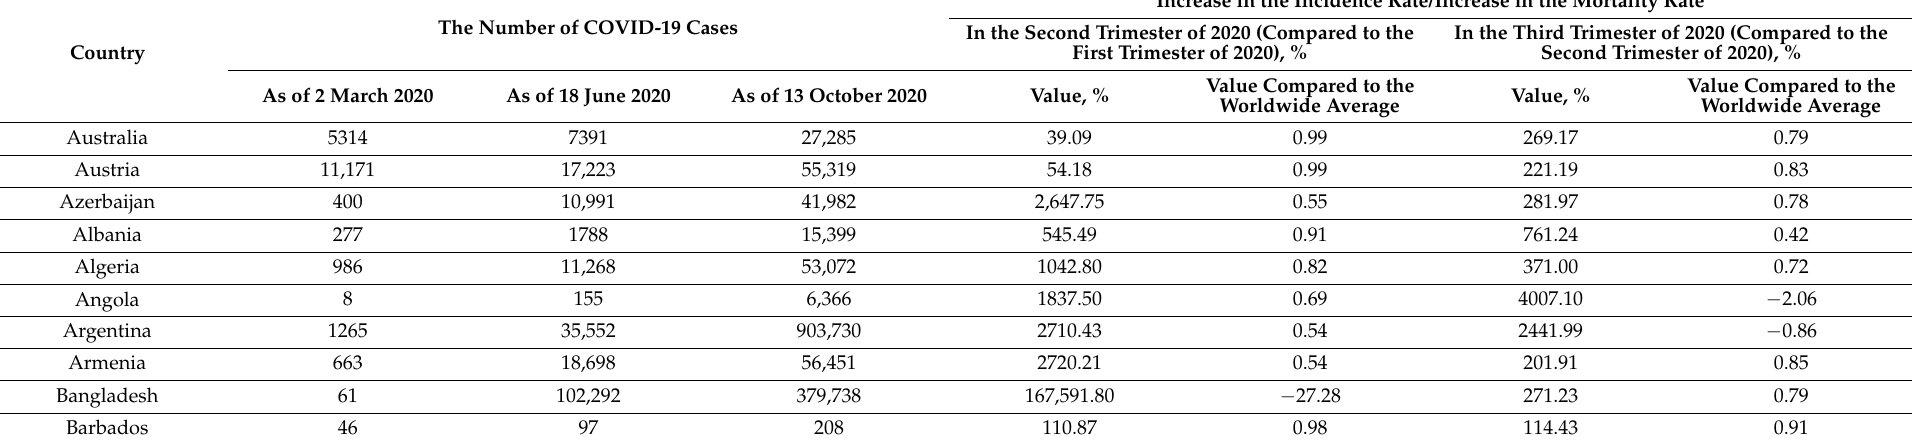
Table A3. COVID-19 incidence statistics for each trimester of 2020.